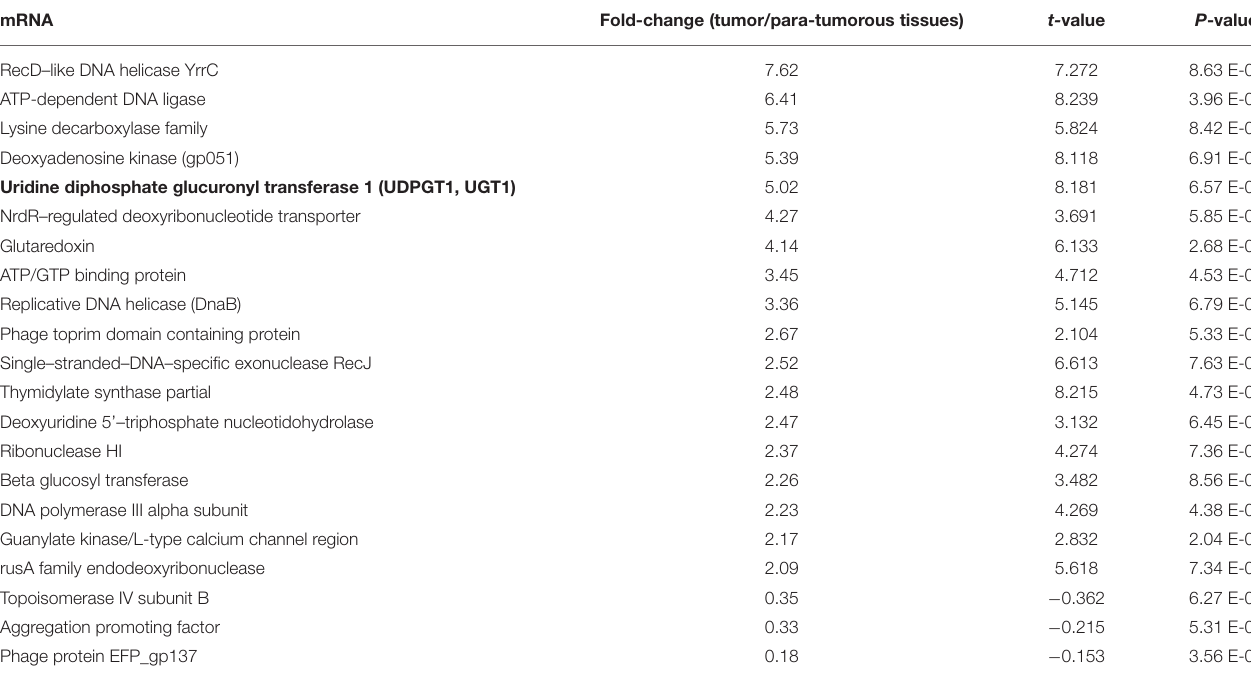
TABLE 2 | Significantly differentially expressed (fold change ≥ 2 and adjusted p ≤ 0.05) genes in various comparisons. mRNA Fold-change (tumor/para-tumorous tissues) t- value P